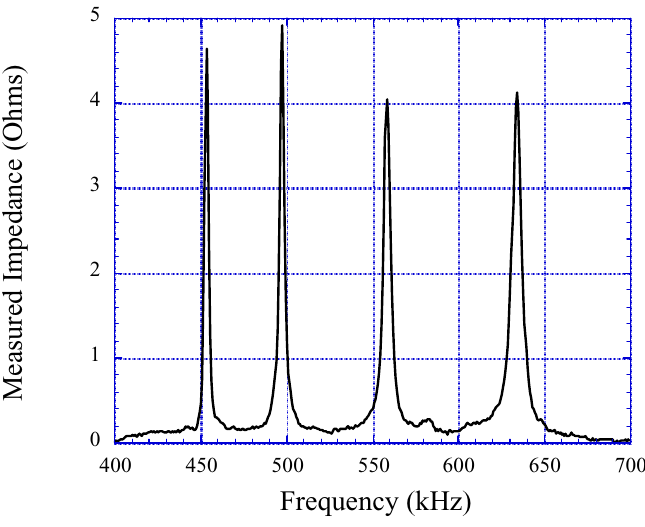
Figure 16. The frequency response of the four-element sensor array measured by inserting the sensor array into a solenoid. The impedance of the solenoid is eliminated with a background